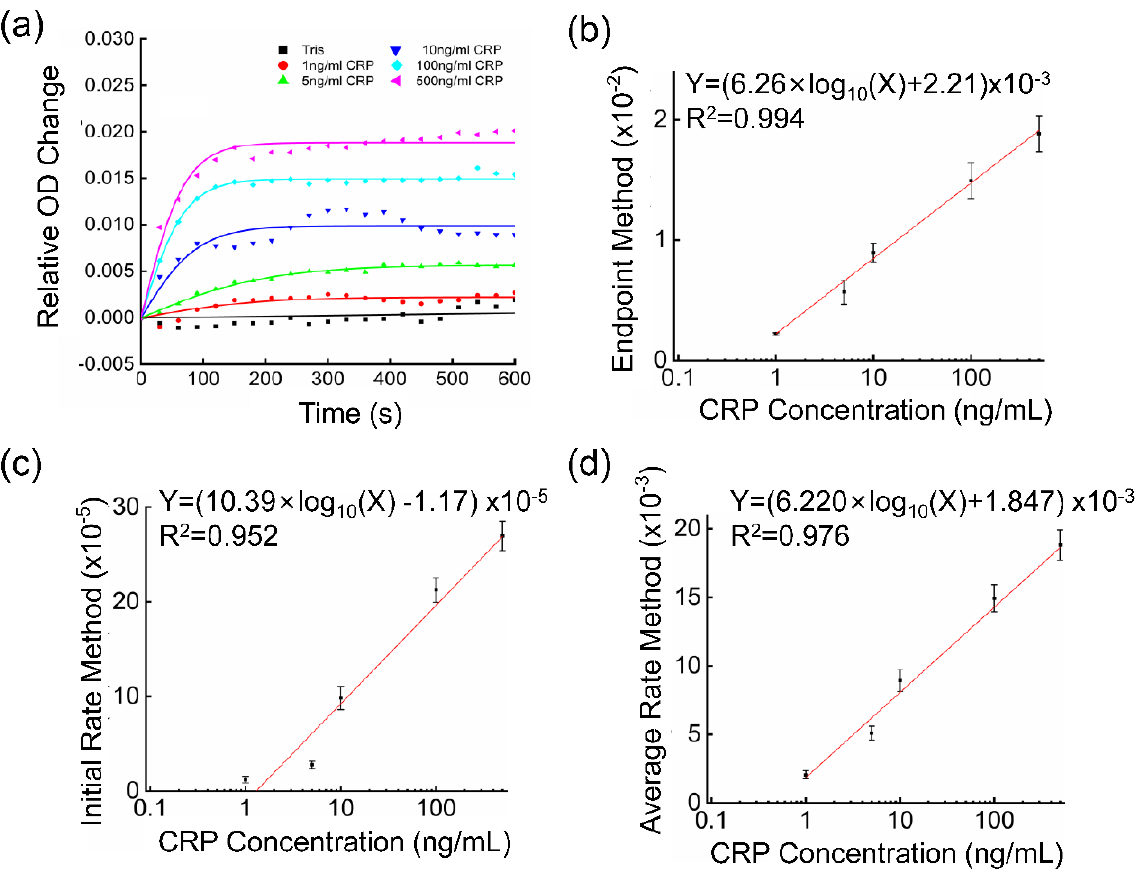
Table S1. At the beginning of the kinetic reaction (x = 0), the relative OD change was 0. Therefore, the constant − 1/2 was used to adjust the initial value. The parameter “A” reflects the relative OD change in the final steady state, and the parameter “B” partly reflects the rate at which the reaction reaches its equilibrium state.